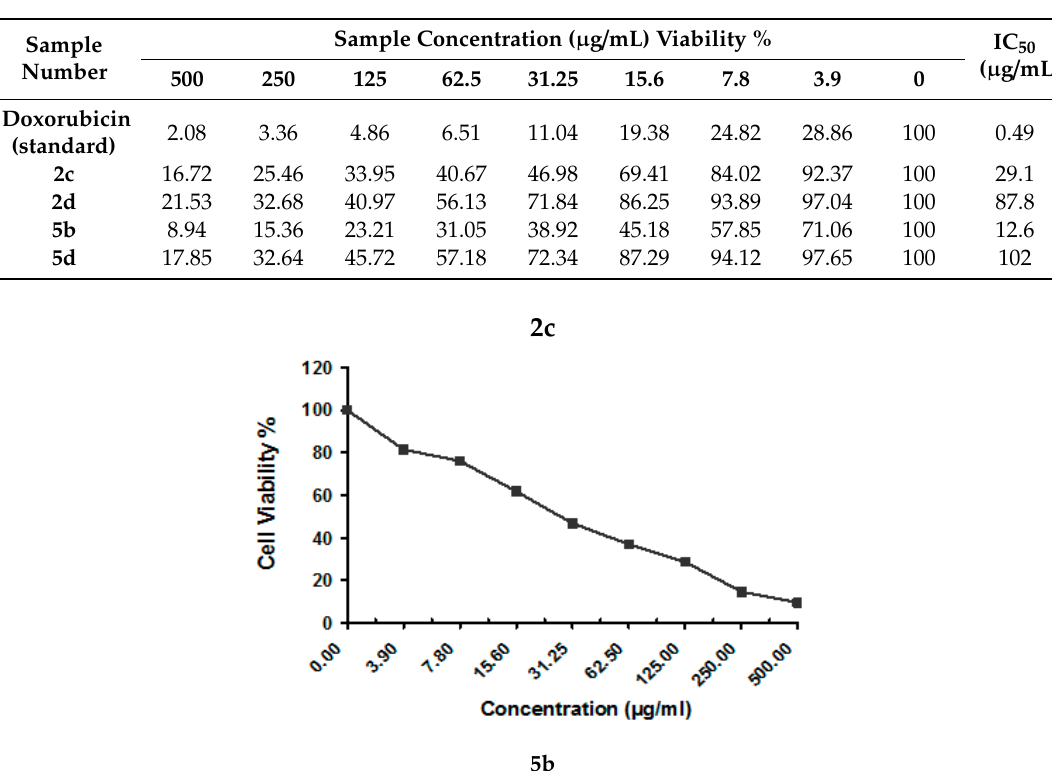
Table 6. Viability values and IC 50 of assessed thiazolines and Doxorubicin against colon carcinoma cells (HCT-116) Cell Line.